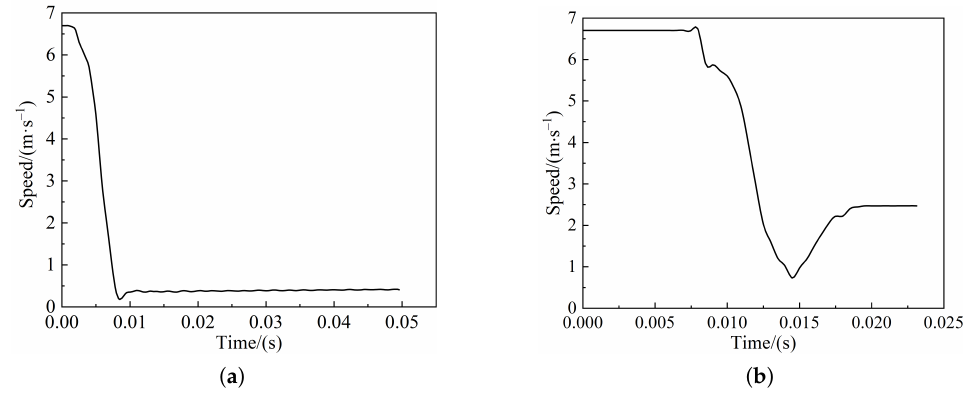
Figure 12. Pendulum speed–time curve during side collision: ( a ) Pig model pendulum curve; ( b ) cow model pendulum